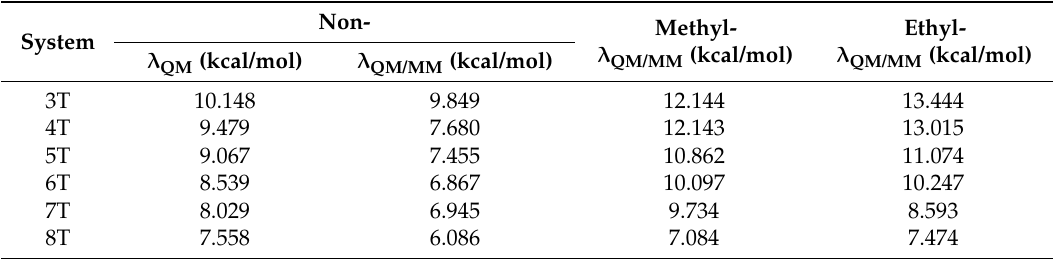
Table 2. Reorganization energy for non-, methyl-, and ethyl-substituted 3T–8T P3AT from both QM and QM/MM